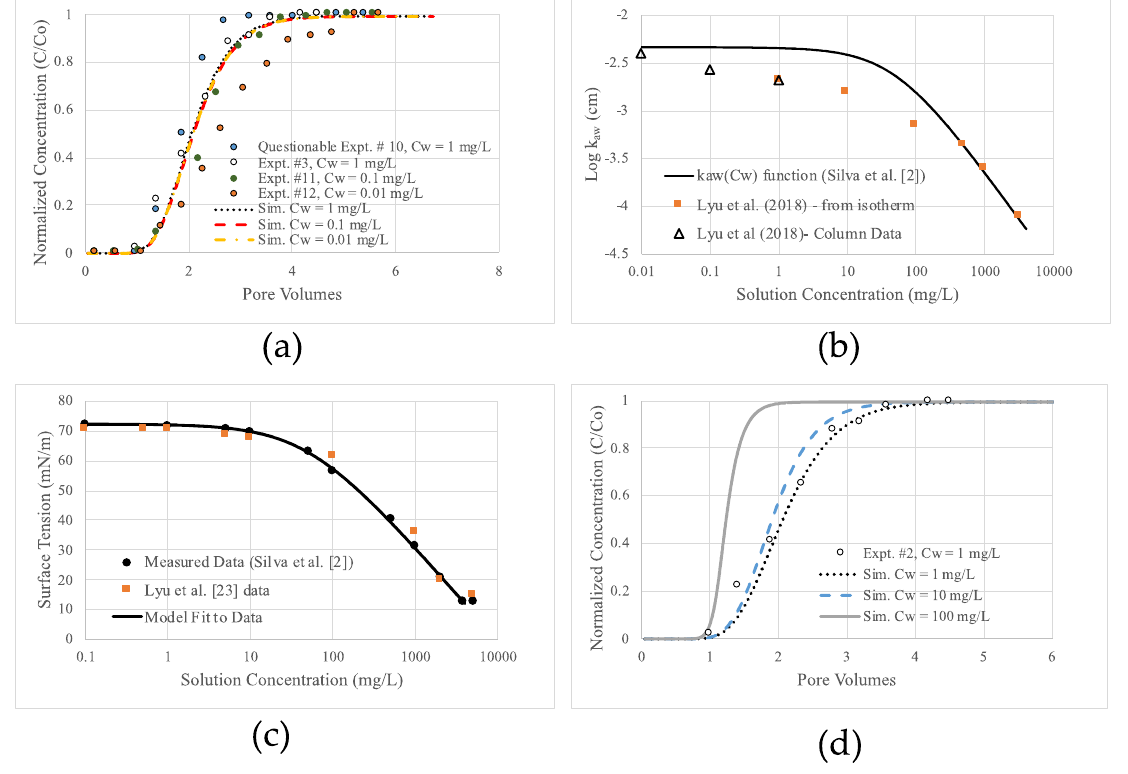
Figure 3. Experimental and simulated results for PFOA transport in water-unsaturated sand: ( a ) Experimental and simulated breakthrough profiles at di ff erent C w , ( b ) comparison of k ia ( C w ) relationshps, ( c ) comparison of PFOA surface tension isotherms, ( d ) retention dependence on C w provided by the modified HYDRUS simulator. All experimental data reproduced from the work of Lyu et al. [23] unless otherwise noted.